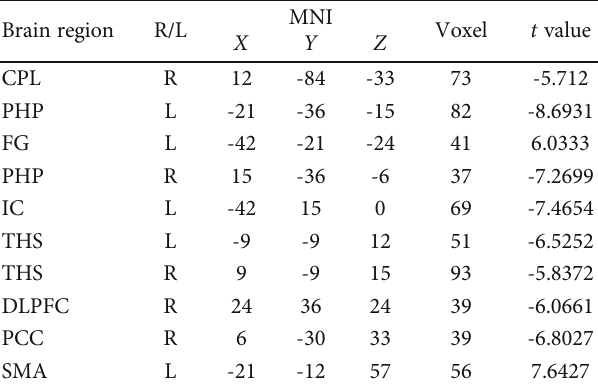
Table 2: Locations of the regions showing signi fi cantly altered EC with the rACC in placebo status compared with pain status in IG ( p < 0 : 05 , FDR < 0 : 05 ).